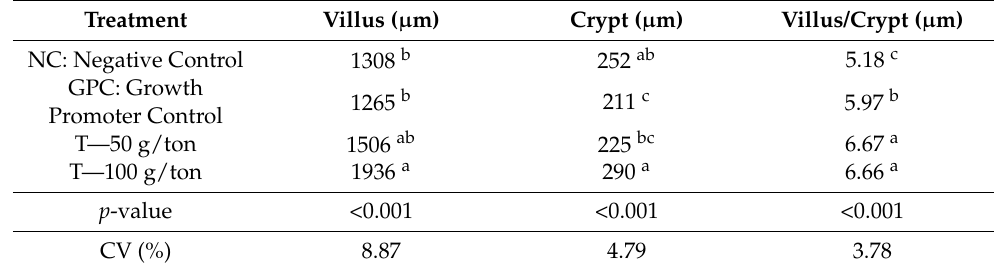
Table 4. The villus, crypt, and villus/crypt ratio of the jejunum of broilers fed an antimicrobial blend to replace growth